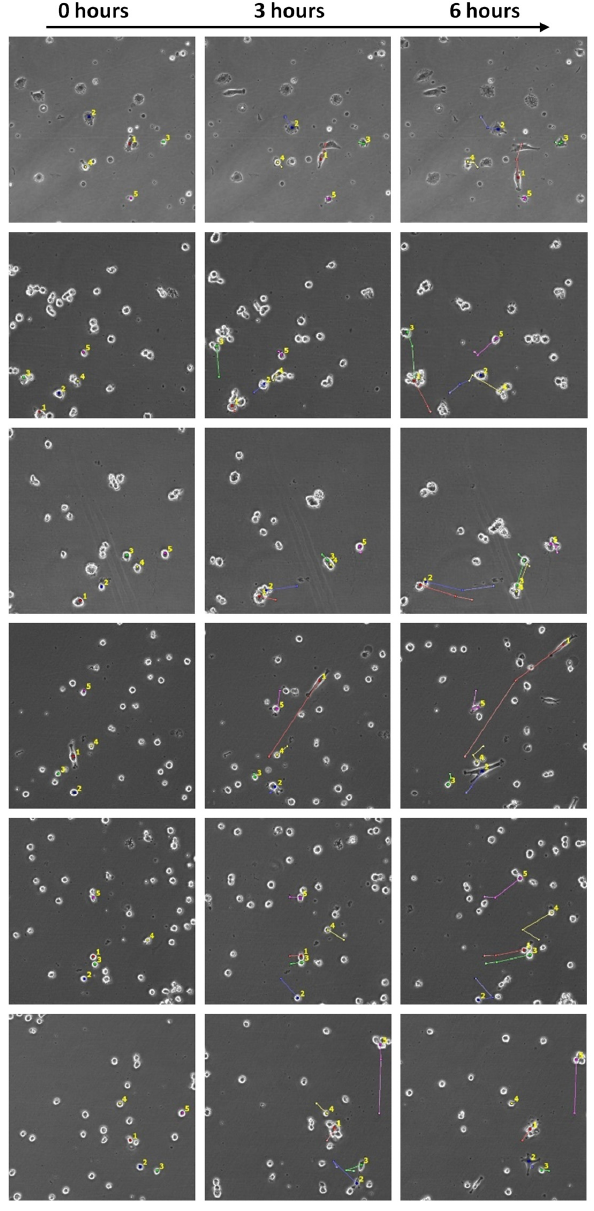
Figure 8. Representative images of migrating cells. Colored lines correspond to the cell track. Phase contrast microscopy, 10 × magnification.